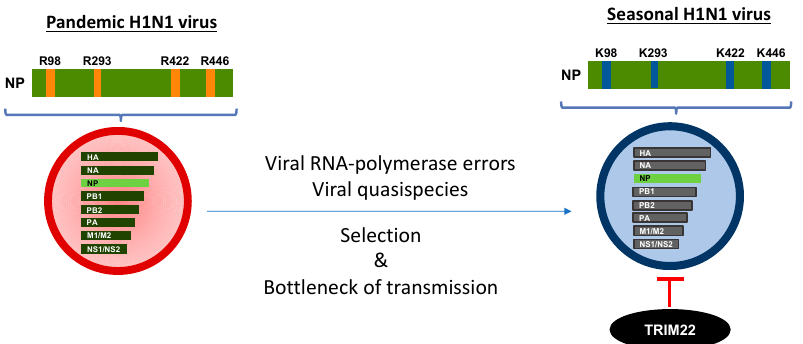
Figure 2. Evolution from pandemic to seasonal IAV has shaped TRIM22 restriction. Pandemic viruses are resistant to TRIM22 inhibition as their NP is endowed with four arginine (R) residues that progressively mutate into lysine (K) residues, becoming the target of the U3 ubiquitin ligase activity of TRIM22. The transition of R into K is dependent on viral polymerase errors that generate viral quasispecies either characterized by one, two, three or four K residues. However, a bottleneck of transmission favors the emergence of an IAV NP susceptible to TRIM22 restriction. This phenomenon is likely related to the general rule of viral evolution which endows the virus with the ability to become more transmissible and less pathogenic.